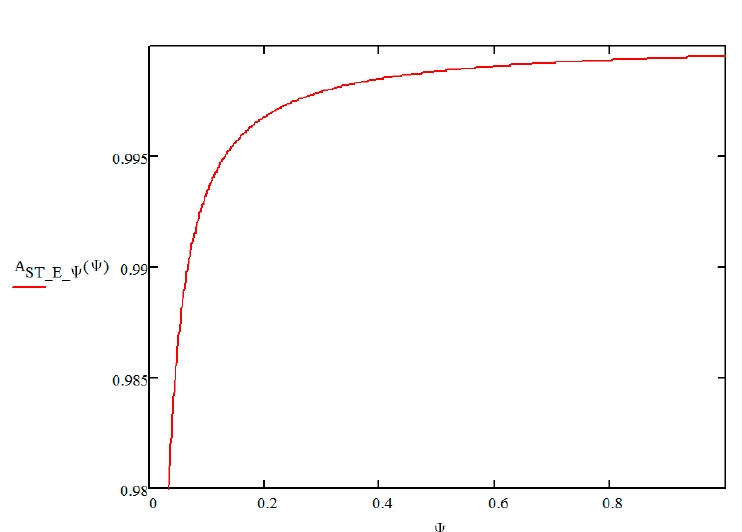
Figure 2. Graph depicting the impact of the number of replaceable modules of a manual toll collection station on its readiness index value. Source: own study.